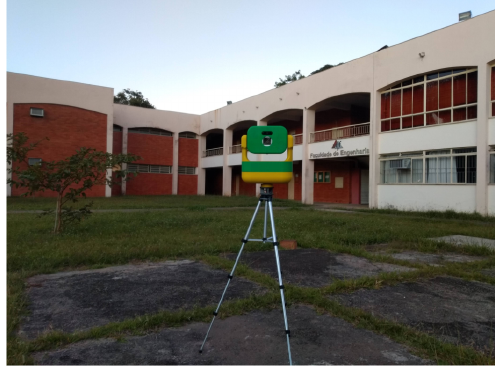
Figure 2. Data Acquisition